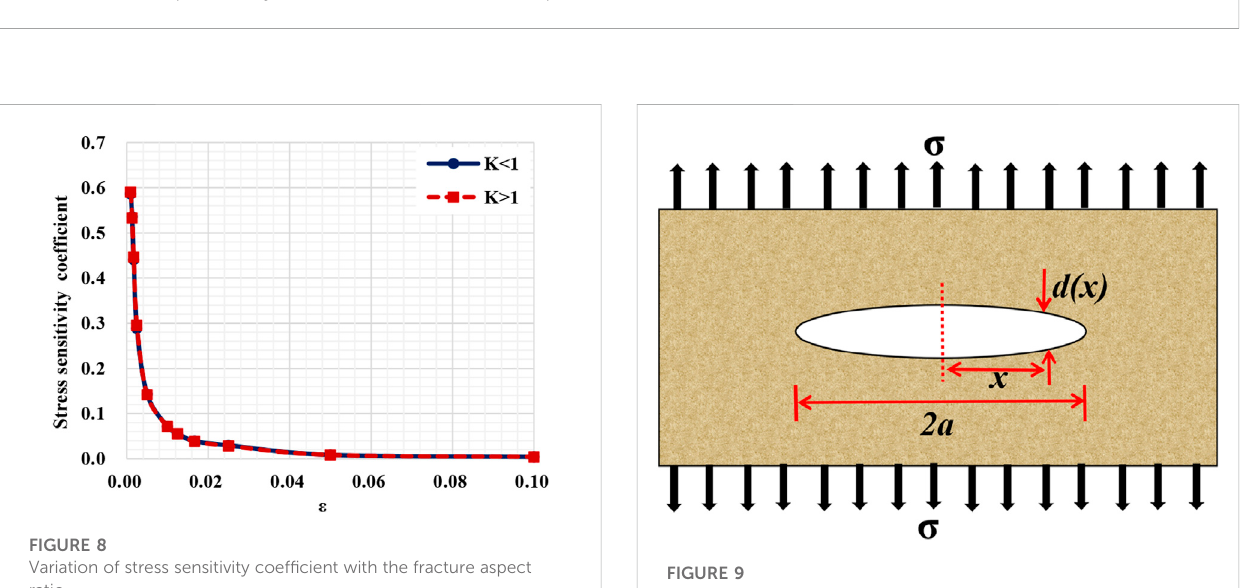
FIGURE 7 Variation curve of permeability ratio of fractures with different aspect ratios with effective stress.